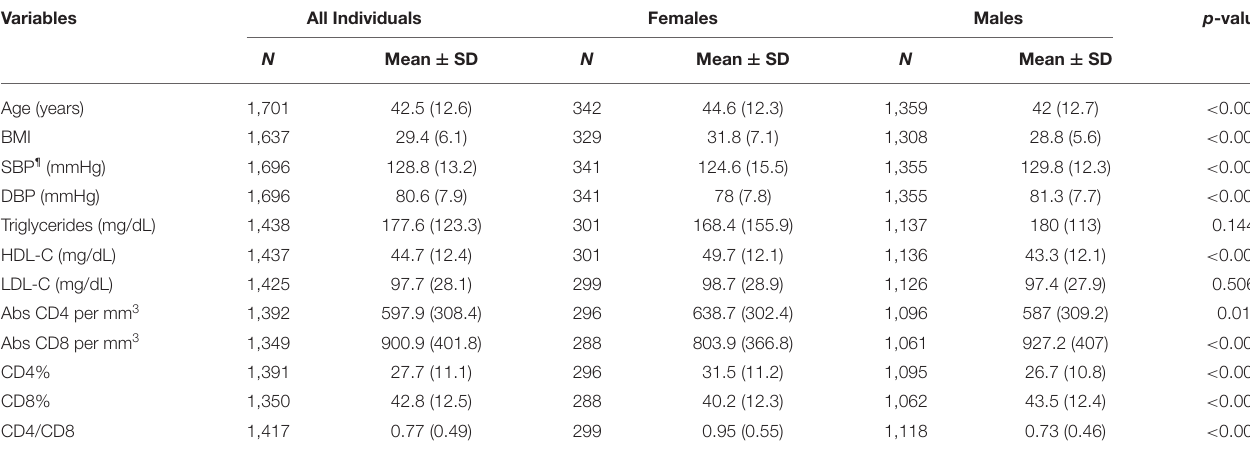
The table shows total/combined and sex-wise mean values of the demographic and clinical characteristics. ¶ SBP, systolic blood pressure; DBP, diastolic blood pressure; Abs, absolute values.